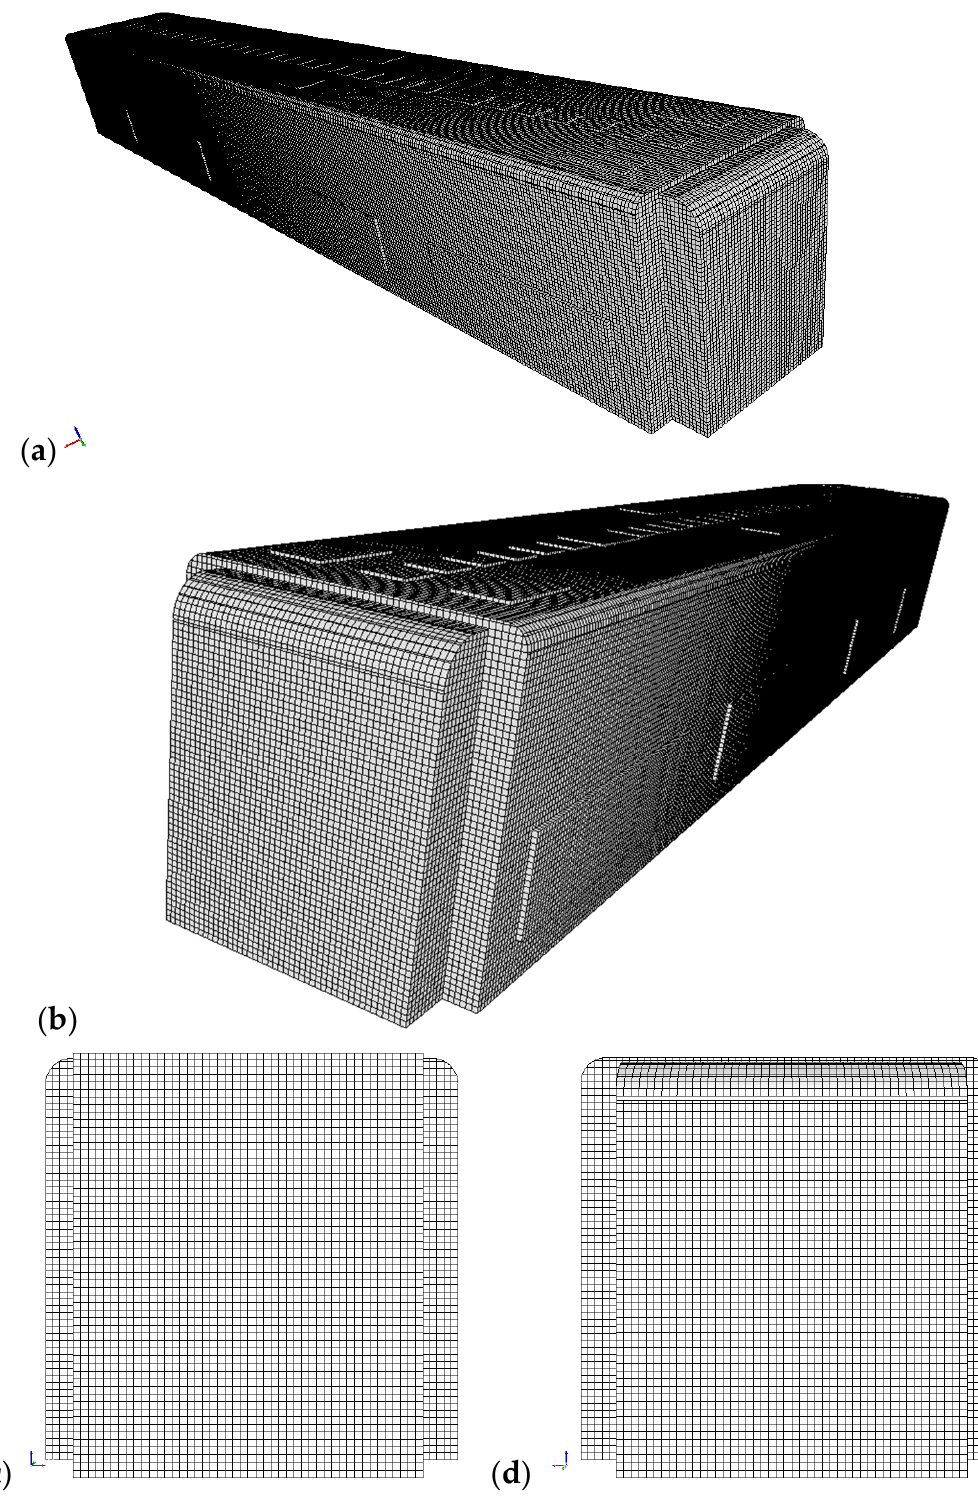
Figure 3. Schematic of mesh configuration for the present work. ( a , b ) are side views of urban subway fine mesh, ( c ) is the back view of fine mesh, and ( d ) is the front view of fine mesh.